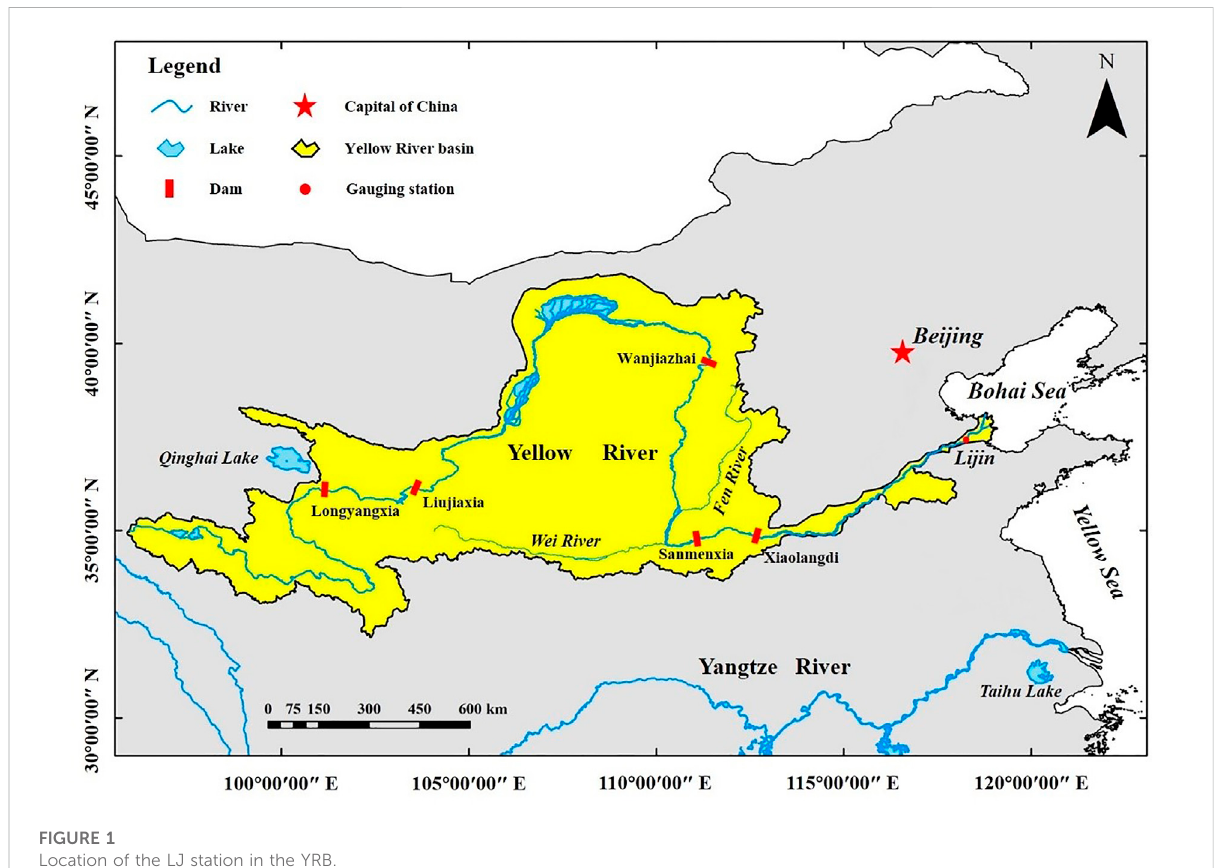
FIGURE 1 Location of the LJ station in the